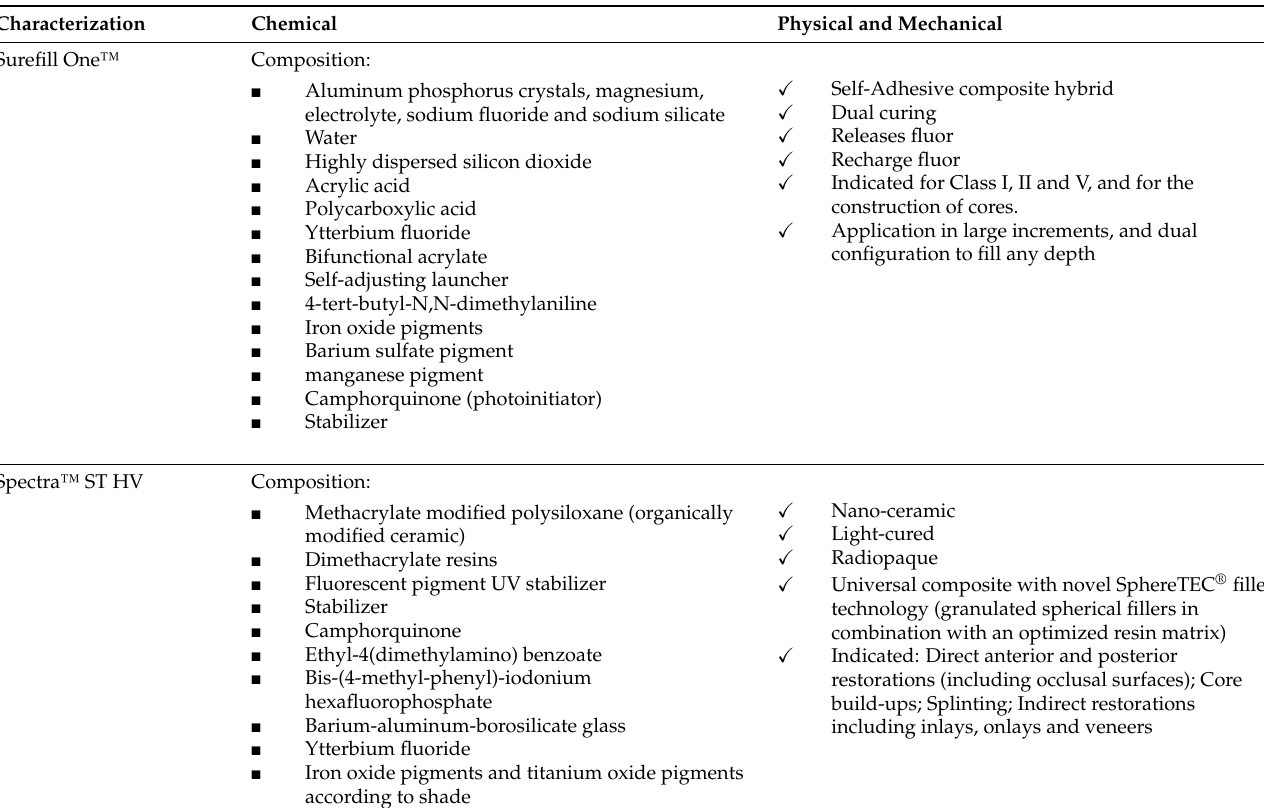
Table 1. Summary of the main chemical, physical and mechanical characterizations of the materials